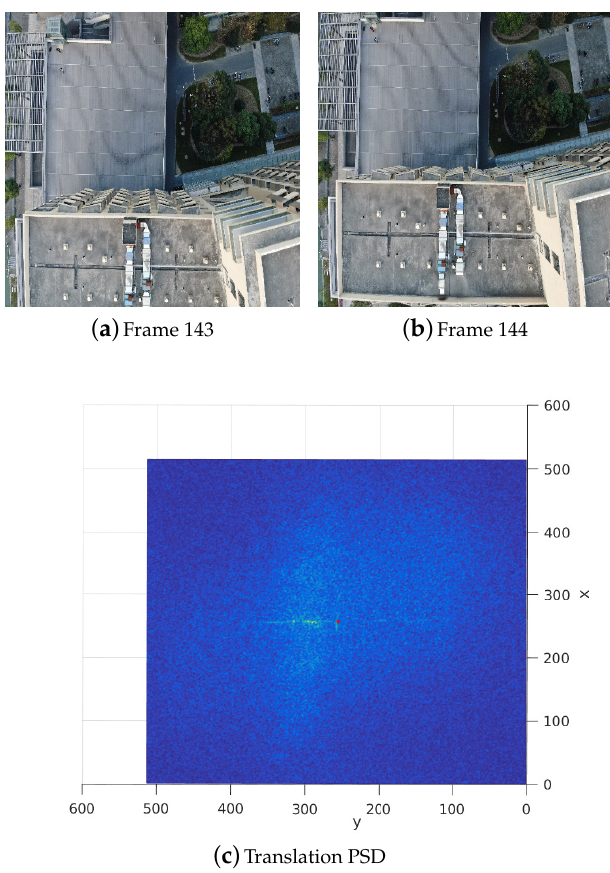
Figure 15. Example line segment in the translation phase shift diagram